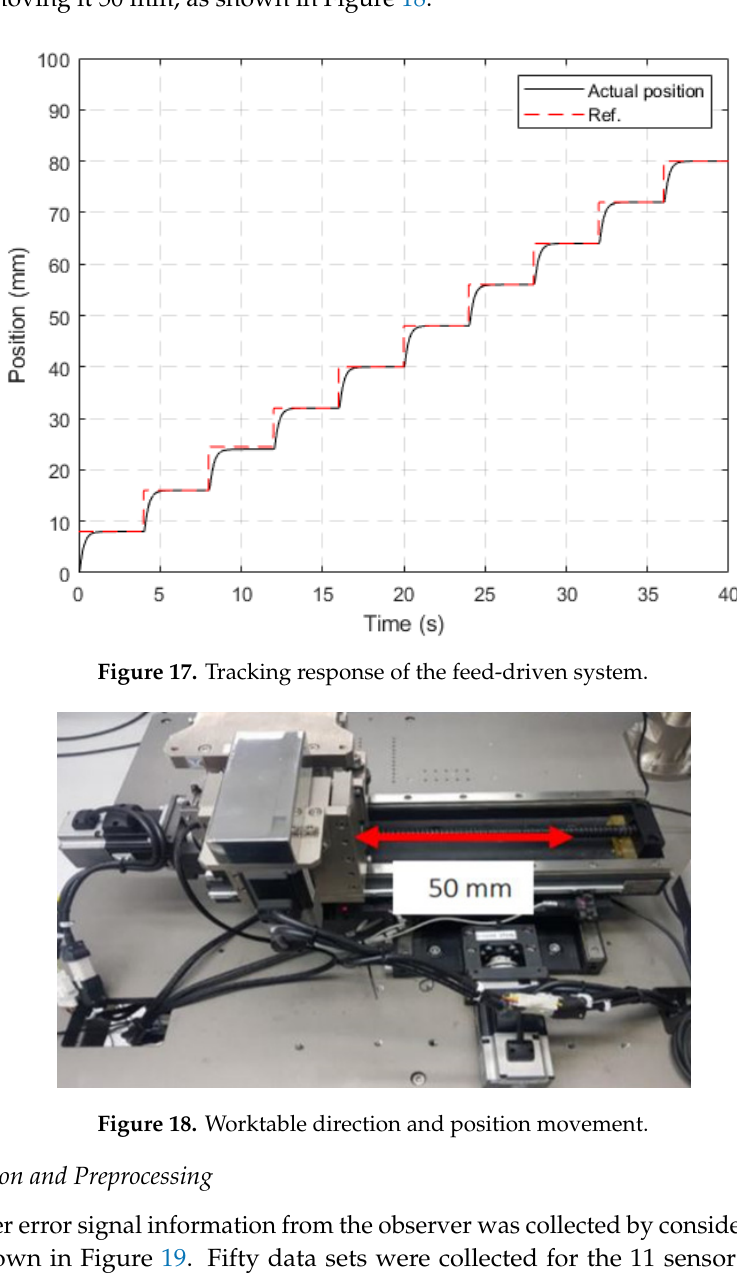
Figure 19. The observer error response.